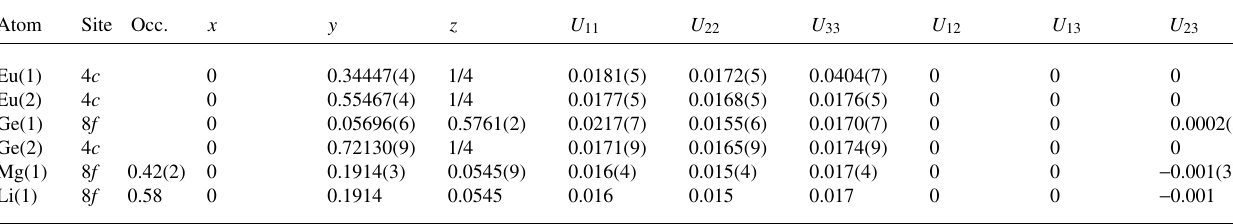
Table 2. Atomic coordinates and displacement parameters (in Å 2 ) .